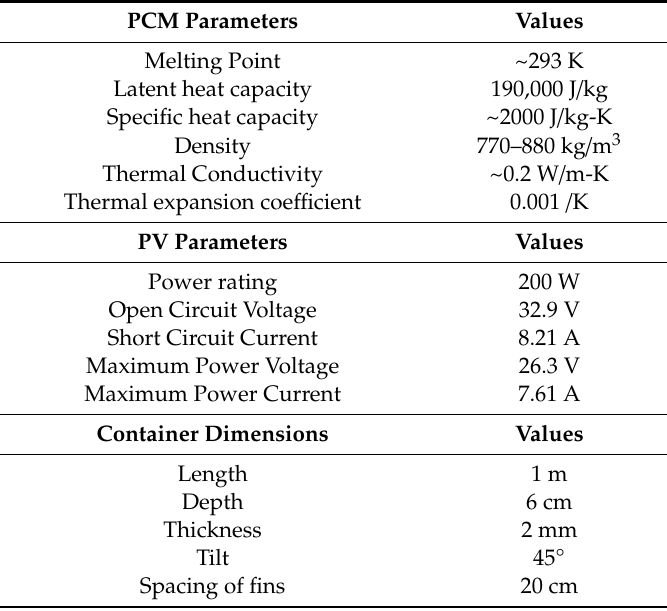
Table 1. Specifications of PCM, PV panel and PCM